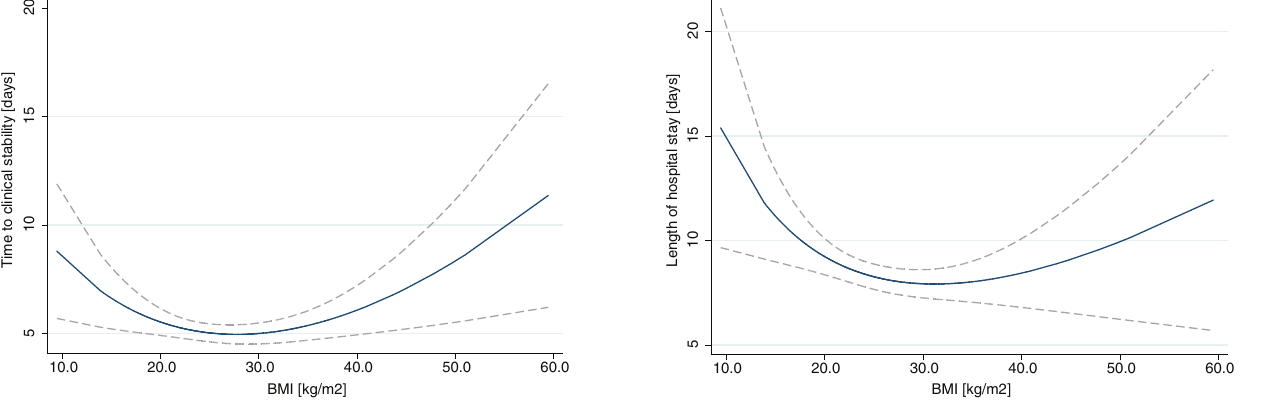
Fig. 1 BMI and time to clinical stability. Fractional polynomial estimation of the association of BMI with the time to clinical stability (TTCS) (blue curve) along with the con fi dence interval of the mean (gray area). There is a U-shaped association between TTCS and BMI.